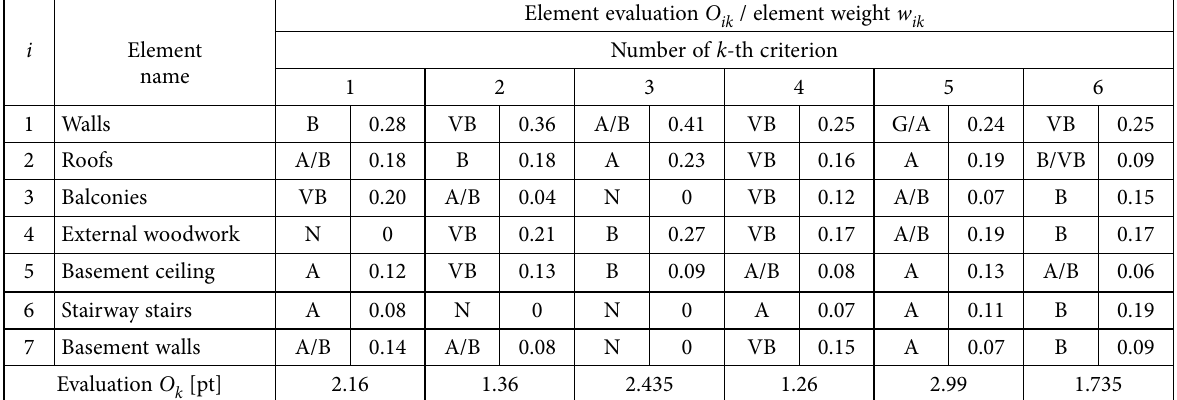
Table 1. The evaluation of adopted building